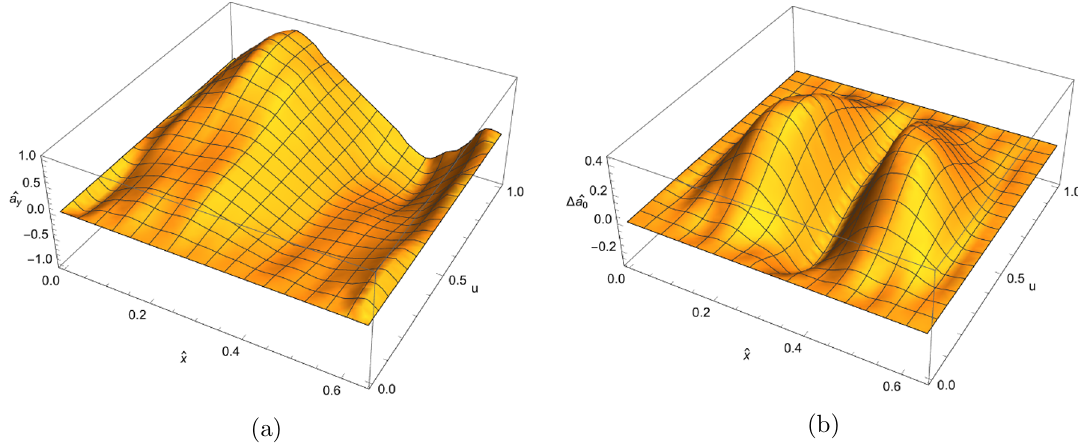
Figure 2 . Plot of a y and the modulation in 4 a 0 = a 0 (